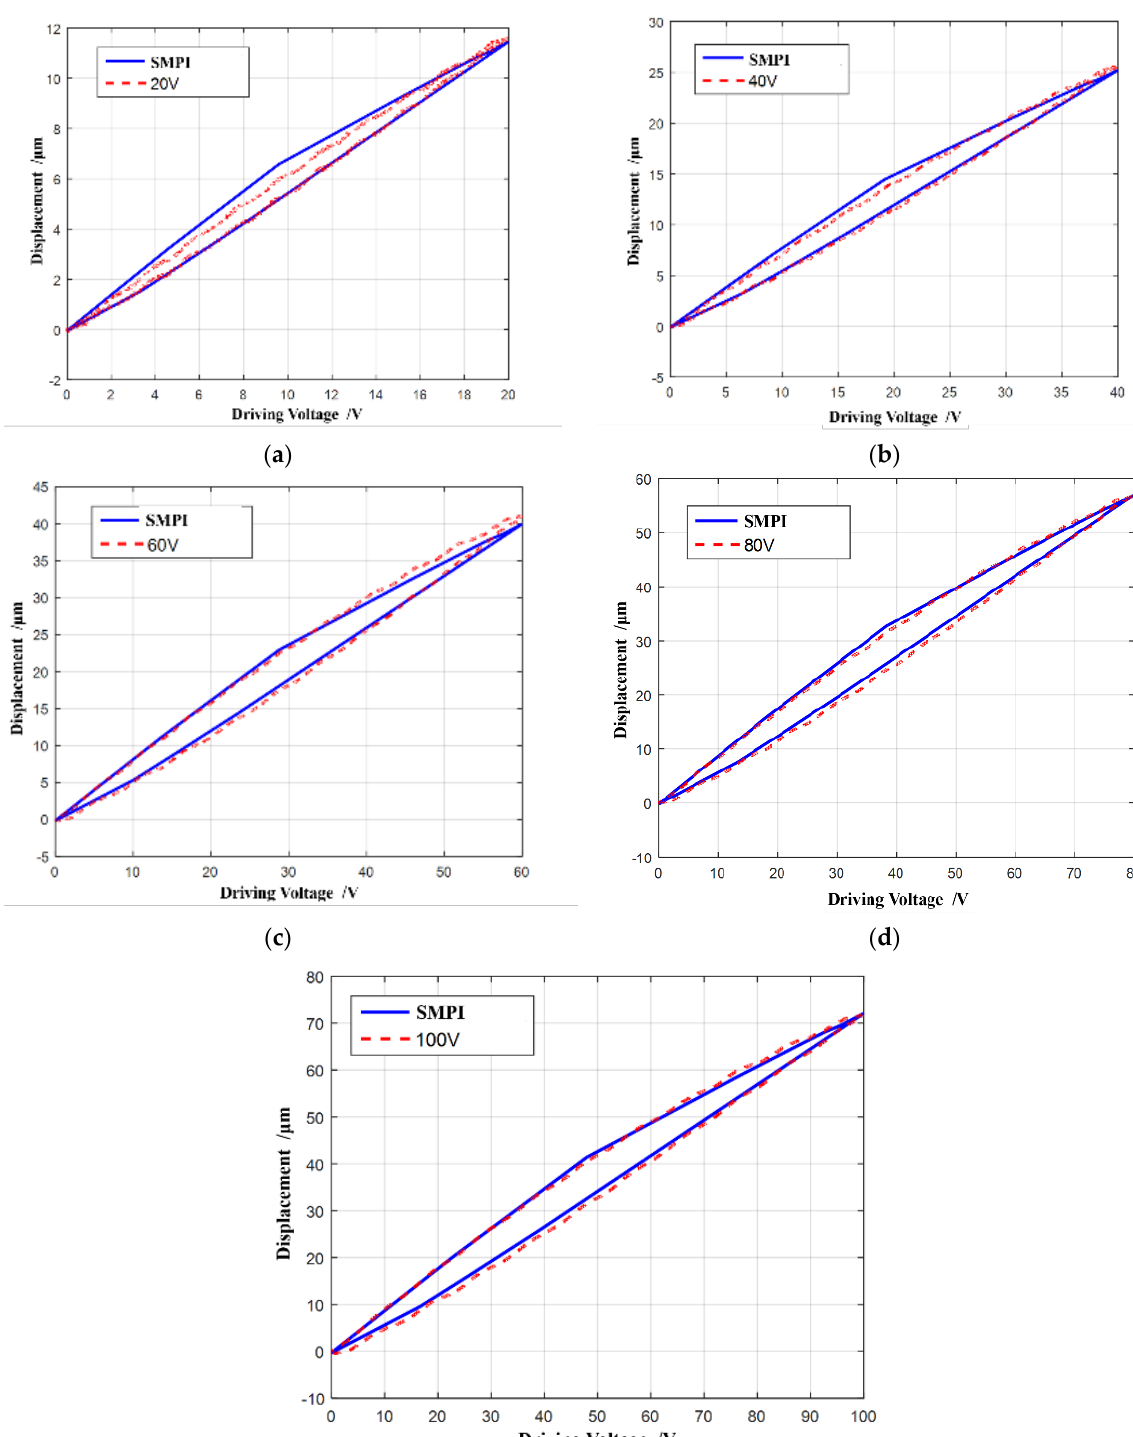
Figure 10. SMPI accuracies on variable voltage amplitudes (20 Hz). ( a ) 20 V; ( b ) 40 V; ( c ) 60 V; ( d ) 80 V; ( e ) 100 V.